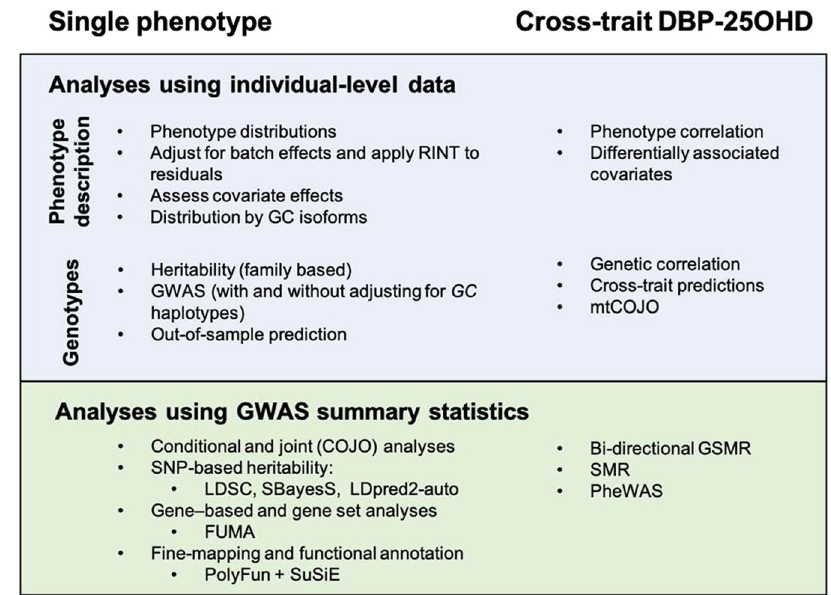
Fig.1|Methods fi gure. FUMAfunctionalmappingandannotationofgenome-wide association studies, SMR summary-data – based Mendelian randomization, GSMR generalized summary-data-based Mendelian randomization, PheWAS